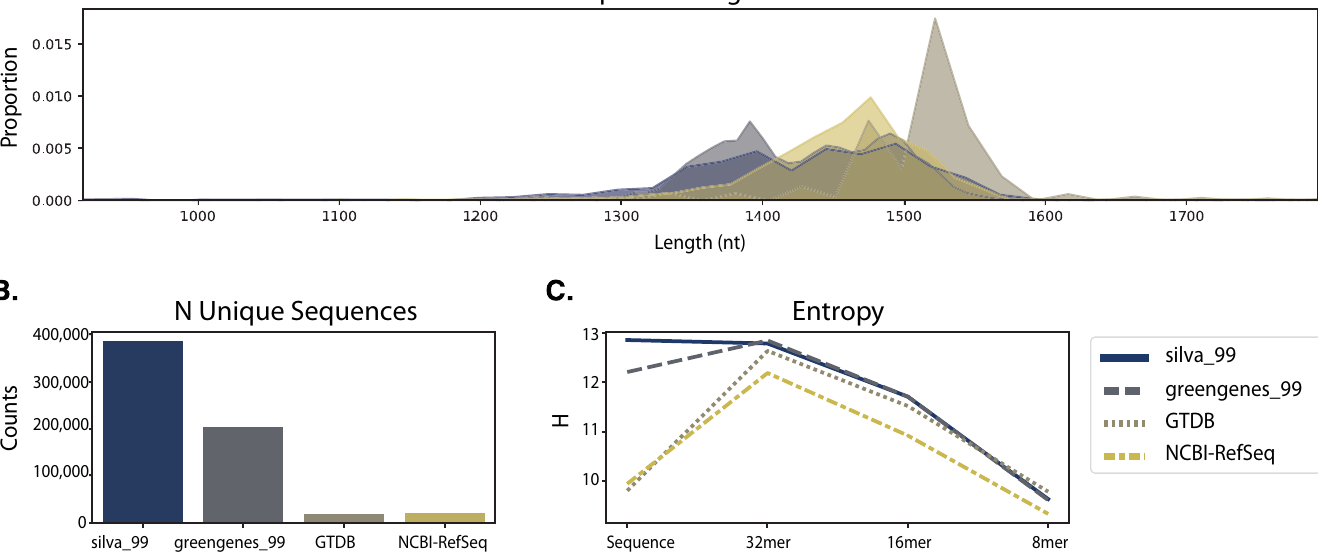
Fig 2. Comparison of sequence information from SILVA, Greengenes, GTDB, and NCBI-RefSeq 16S rRNA gene databases. A, Sequence length distributions (after removing outliers, see materials and methods). B, Number of unique sequences in each database. C, Entropy of full-length sequences and different kmer lengths in each